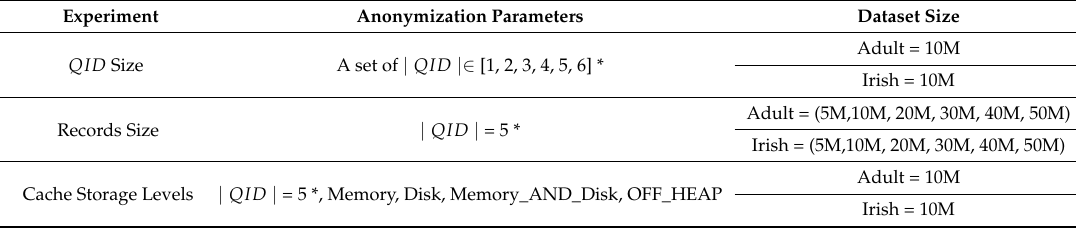
Table 6. Experimental Configurations for Scalability, Performance and Caching ( K - value ∈ { 10, 20, 25, 50, 75, 100} on